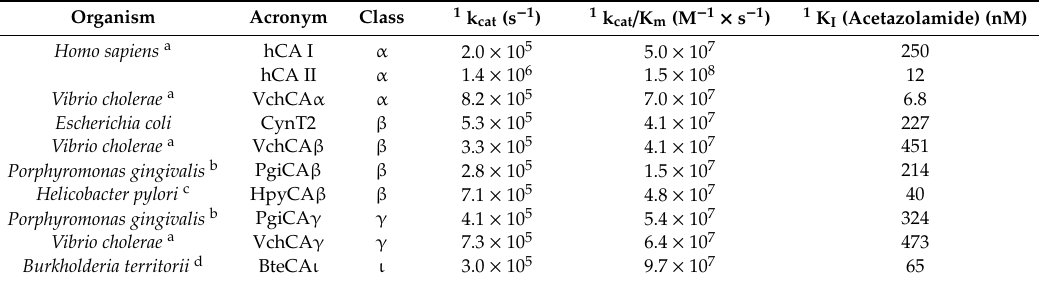
Table 1. Kinetic parameters for the CO 2 hydration reaction catalyzed by the human α -CAs: the cytosolic isozymes hCA I and II; bacterial α -CA: VchCA α ; bacterial β -CAs: CynT2, VchCA β , PgiCA β , HpyCA β , BsuCA219, BsuCA213, LpCA1 and LpCA2; bacterial γ -CAs: PgiCA γ , VchCA γ ; bacterial ι -CA: BteCA ι